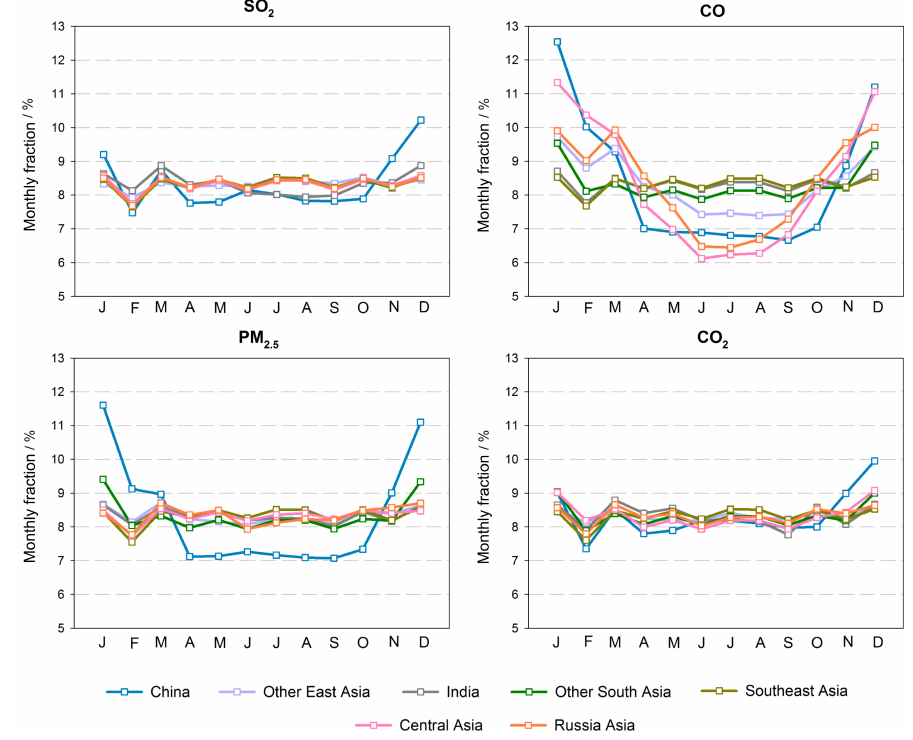
Figure 11. Monthly variations of SO 2 , CO, PM 2 . 5 , and CO 2 emissions by Asian region for the year 2010. Table 7. Intercomparisons of total anthropogenic emissions a among MIX, REAS2, and EDGAR v4.2 for